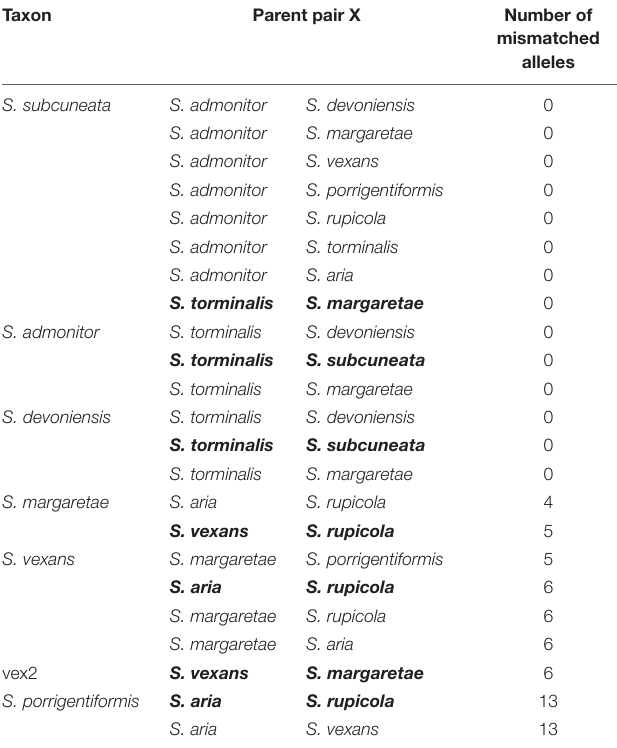
TABLE 2 | Summary of the parentage simulation. Taxon Parent pair X Number of